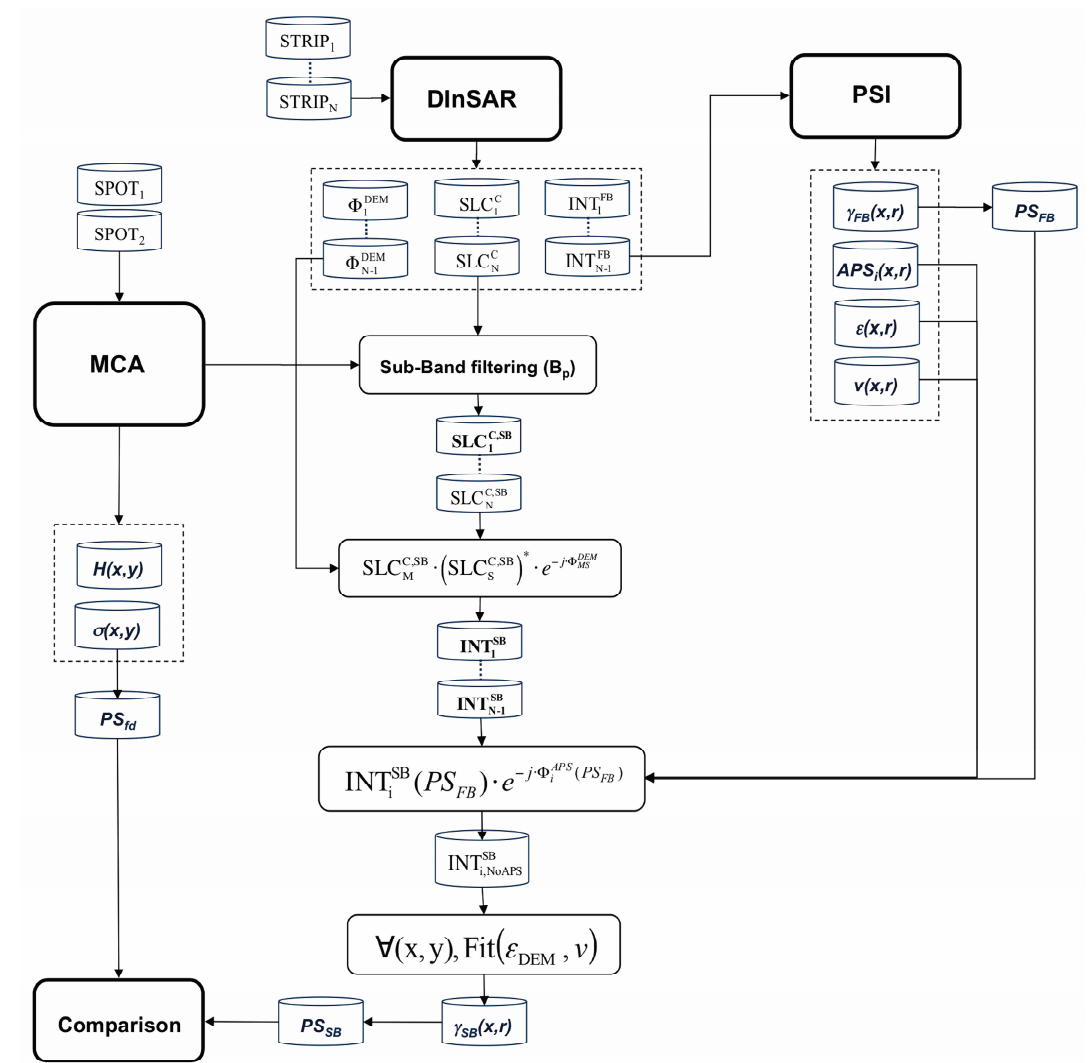
Figure 3. Flow chart of the processing scheme adopted for the comparison between FPS and time-persistent scatterers